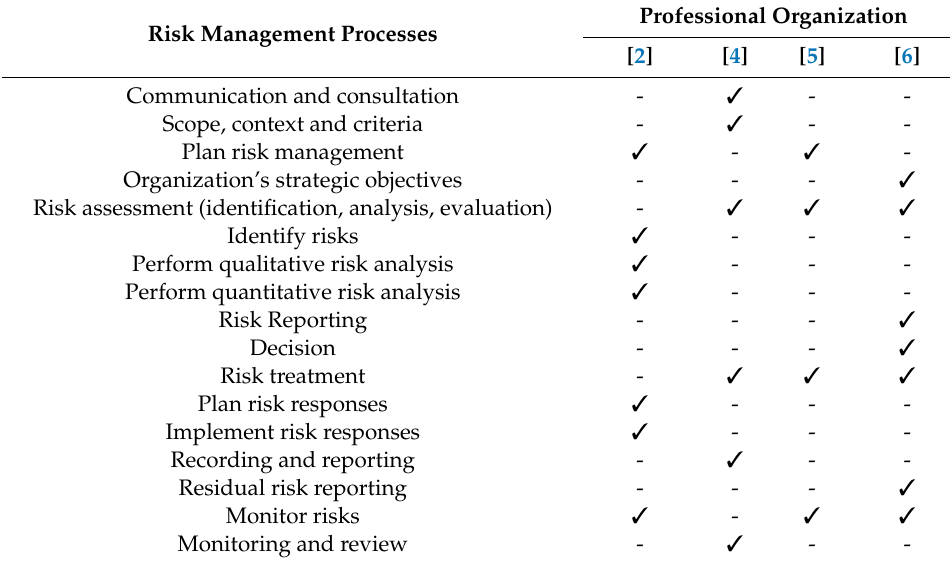
Table 1. General risk management